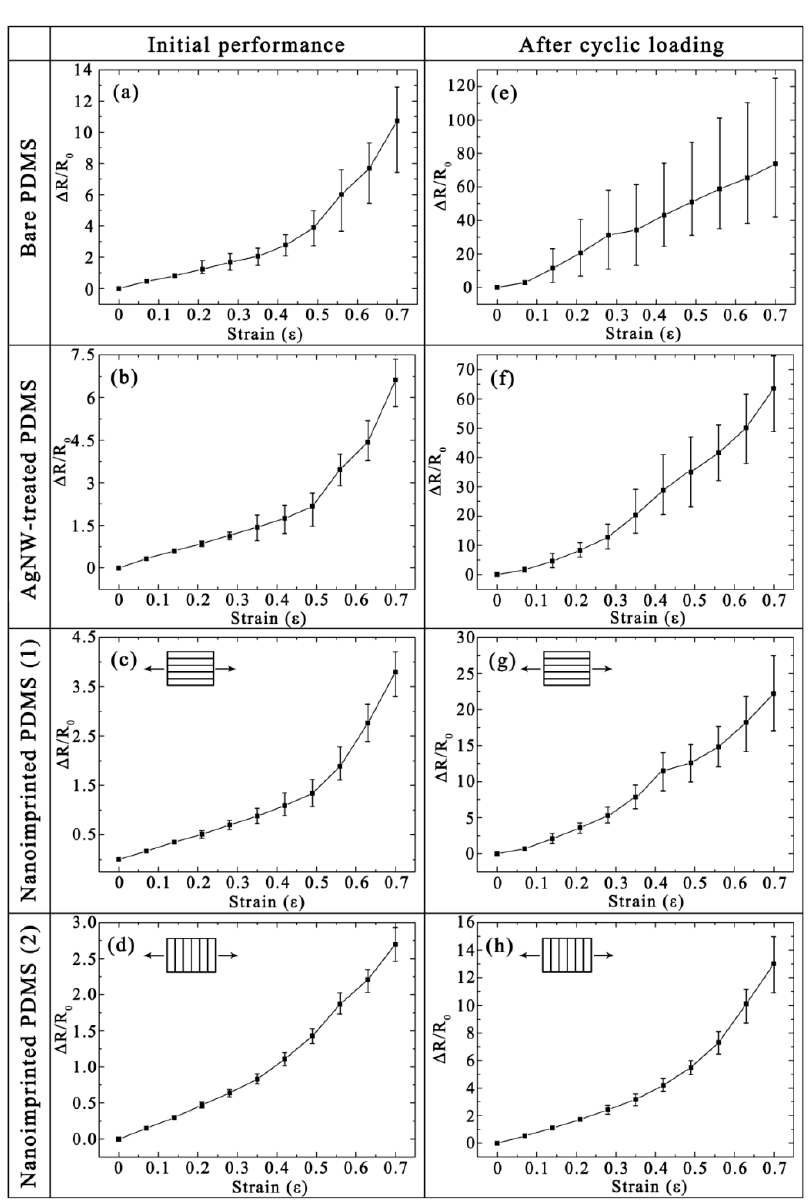
Figure 3. Measured strain-dependent relative Δ R/R 0 of Ag thin film on the bare PDMS, Ag nanowire (NW)-treated PDMS and nanoimprinted PDMS substrates under initial state ( a – d ) and after cyclic loading ( e – h ).